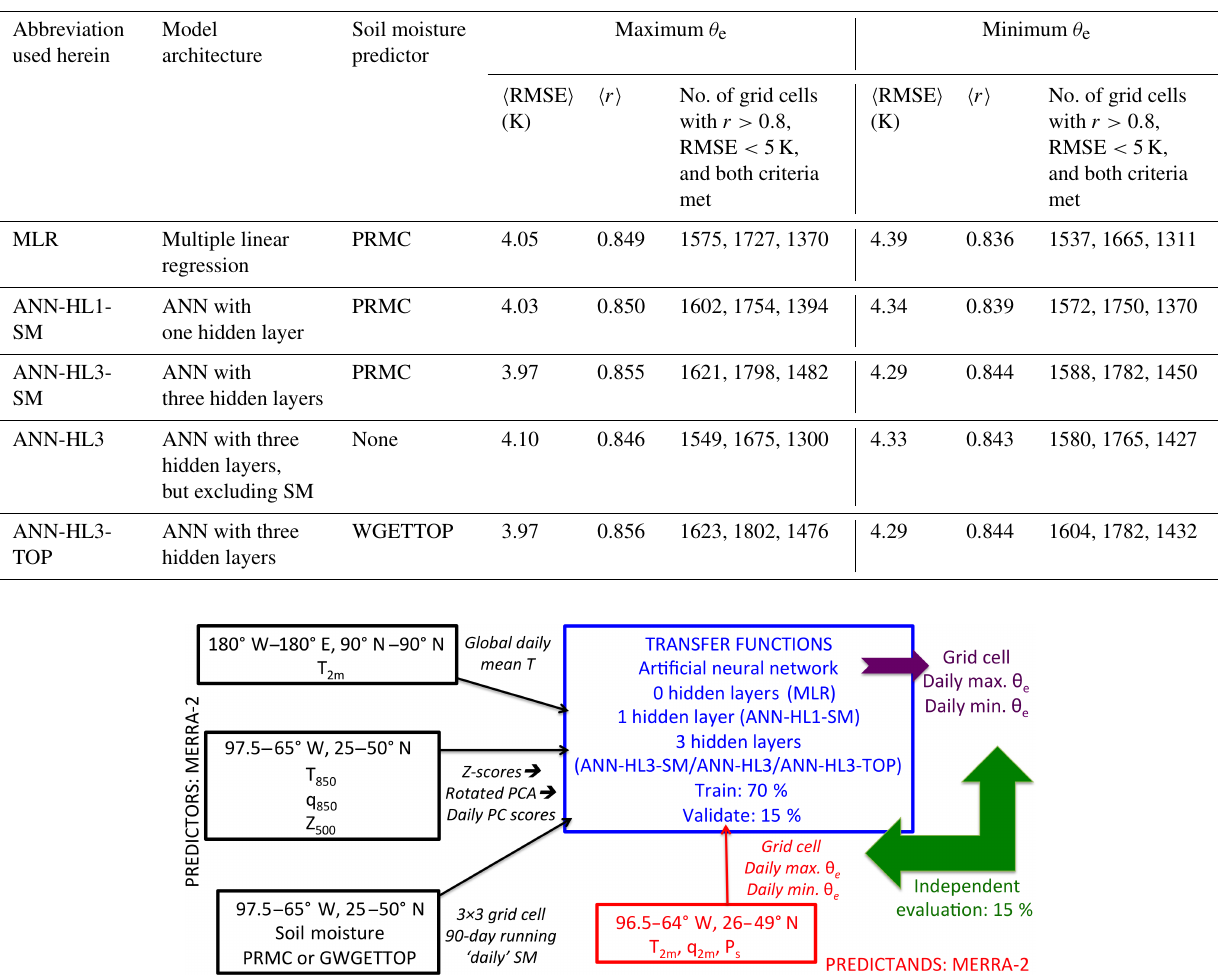
Figure 3. Schematic of the ANN model architecture (model naming convention), data flow, predictors and predictands.